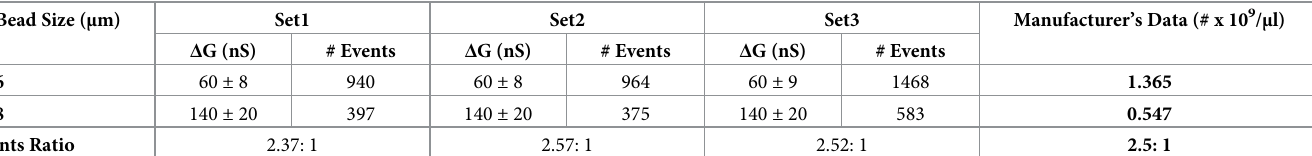
Table 1. Quantification of mixed samples.